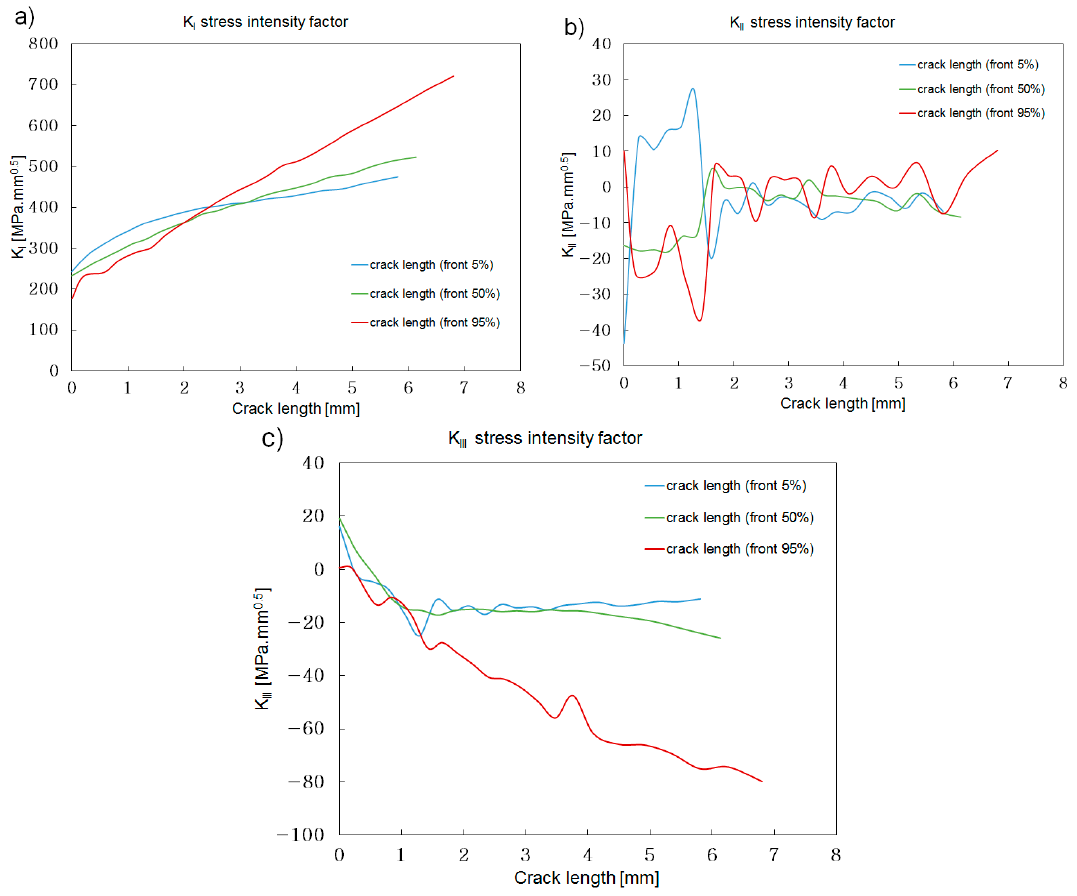
Figure 21. The 45° angle, long flank. Stress intensity along the three crack paths selected: ( a ) K I ; ( b ) K II ; ( c ) K III .